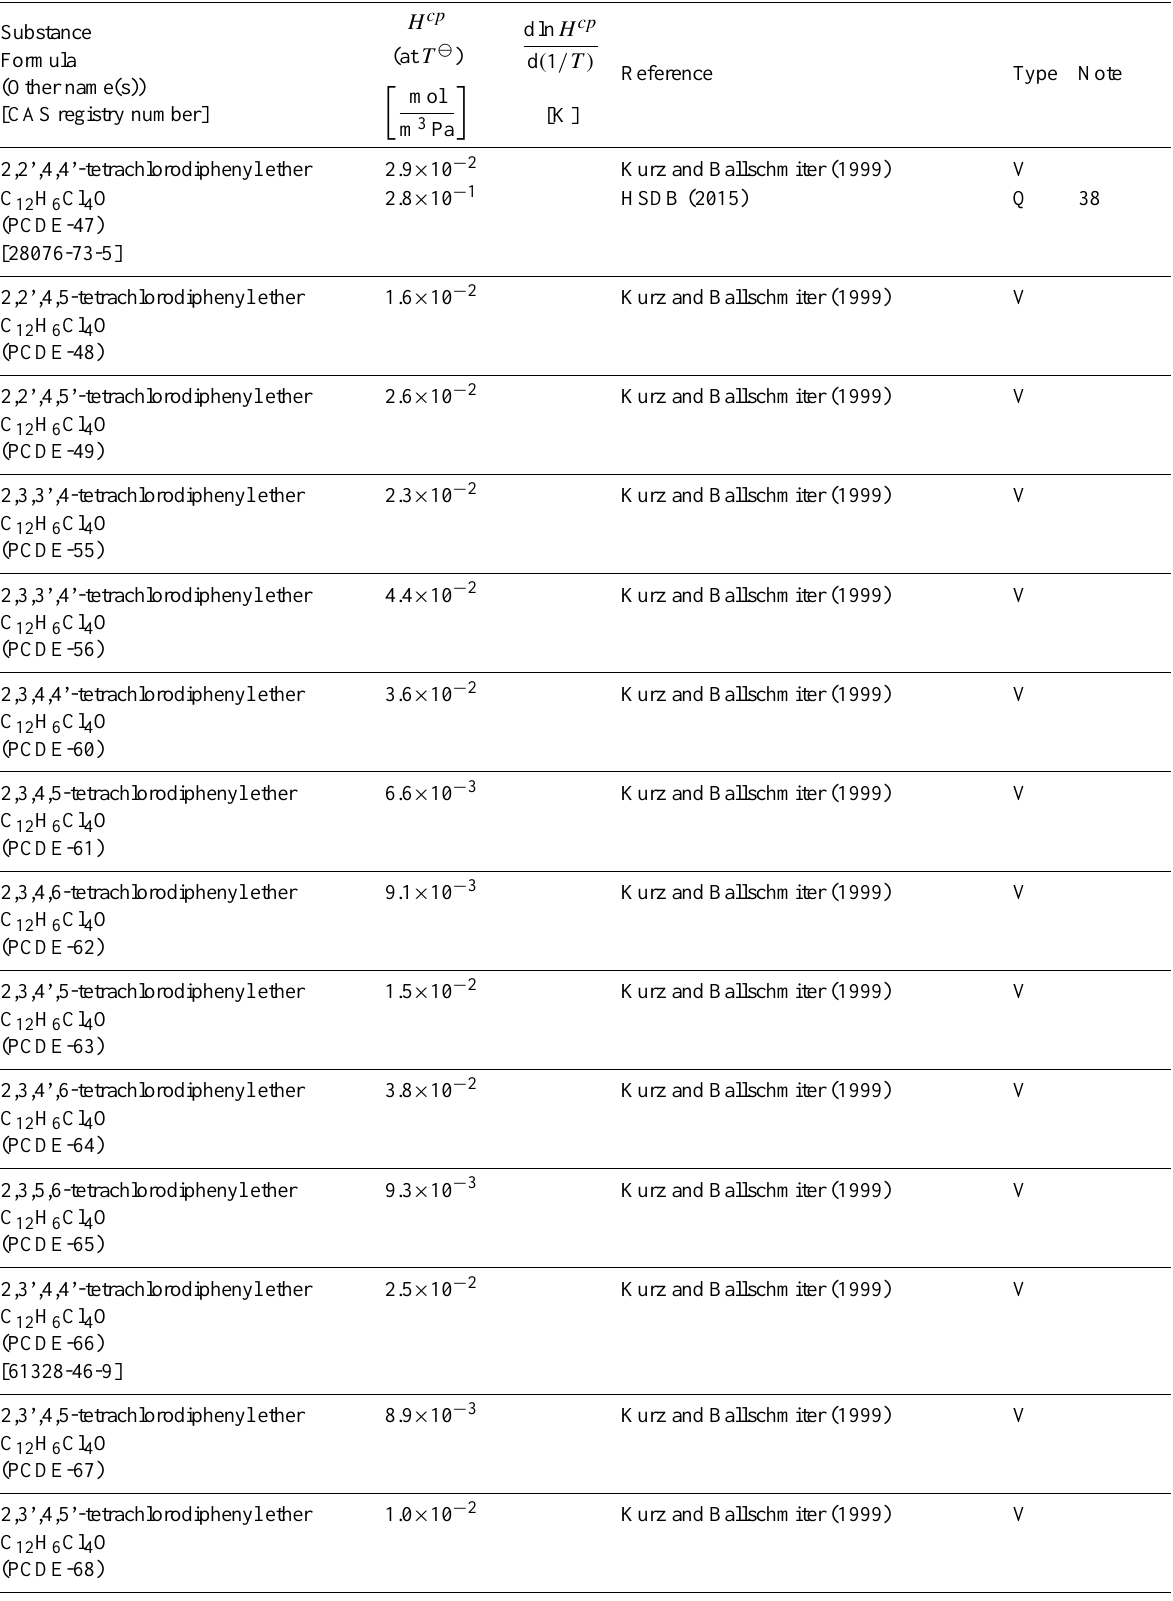
Table 6: Henry’s law constants for water as solvent